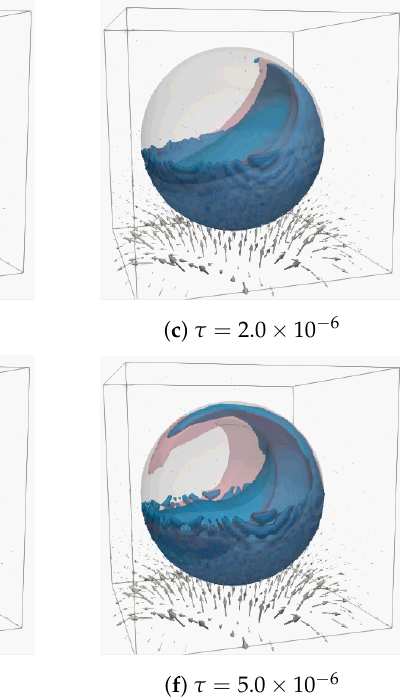
Figure 10. Computational results of Case 1 ( D / L = 1.0, H = − 0.2, b c = 1.0 [T]; i.e., coil is smaller and farther from the tank, and magnetic flux density is medium). The blue color indicates the movement of liquid phase damped by the magnetic force, whereas the pink color indicates that in Case 0 (no magnetic force). The black vectors represent the magnetic field generated by the coil current.